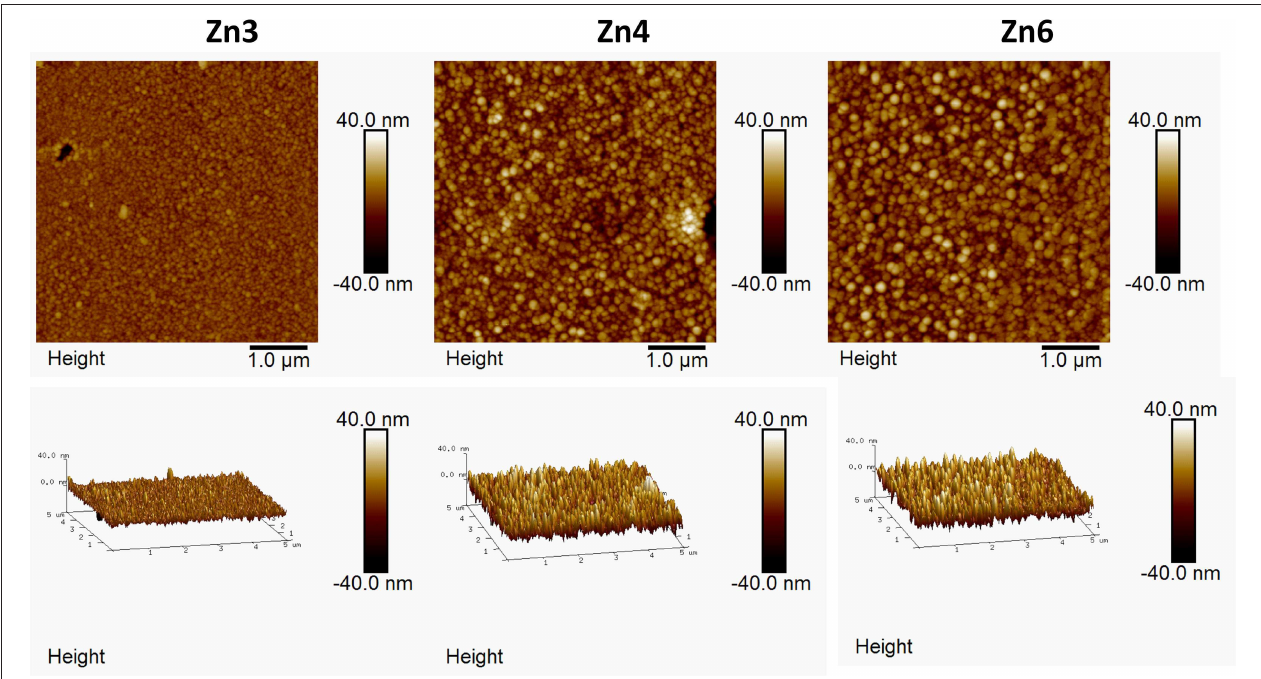
FIGURE 2 | 2D and 3D AFM images of selected ZnO-coated